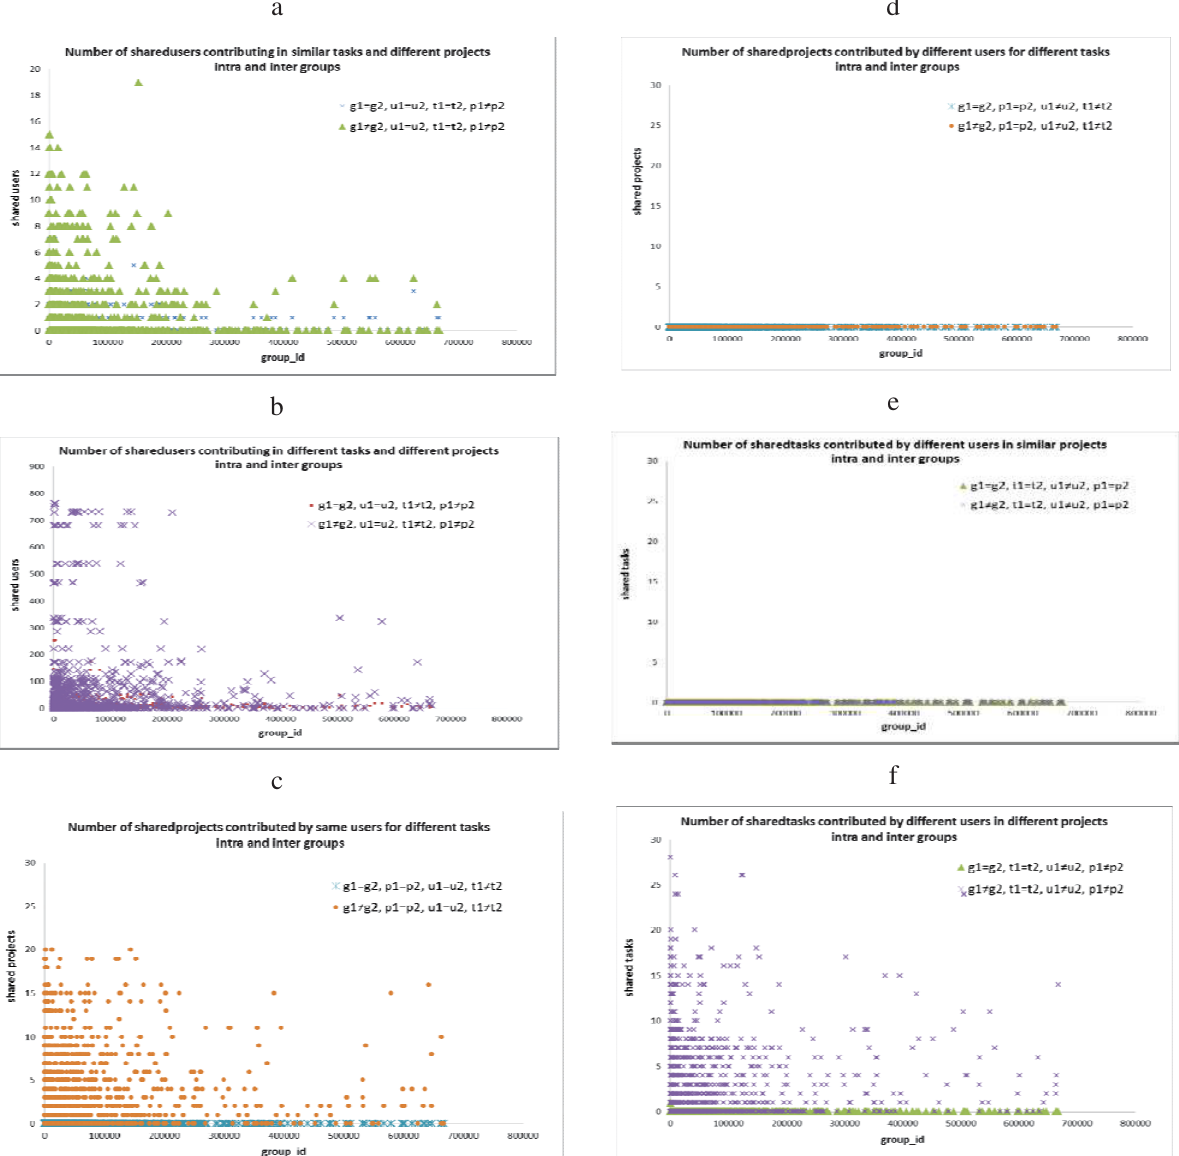
Fig. 4. Illustration of a,b) shared users implying one developer contributing to similar or different tasks and different pro- jects intra or inter groups, c,d) shared projects implying one project contributed by the same or different developers and different projects intra or inter-groups, e,f) shared tasks implying one project task contributed by different developers in similar or different projects intra or inter groups.